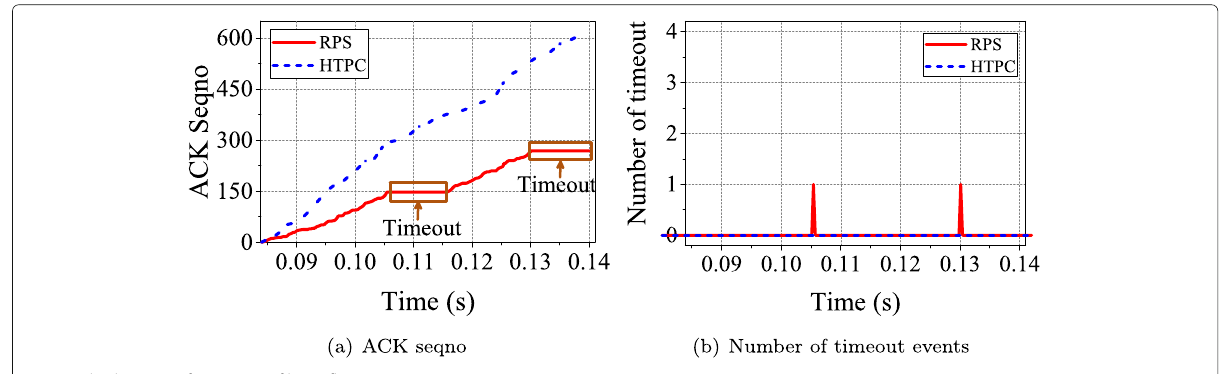
Fig. 7 The basic performance of long